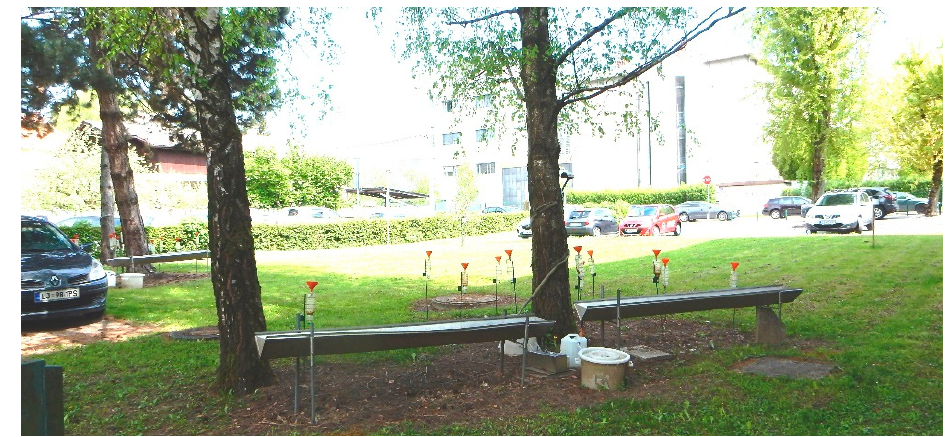
Figure 2. Experimental setup under the